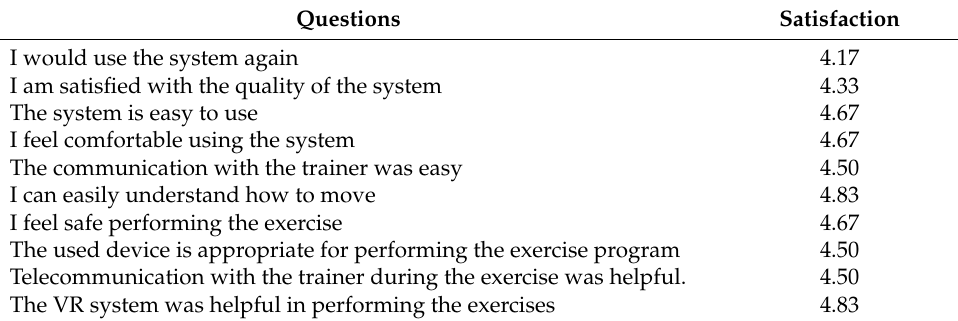
Table 2. Results of modified telerehabilitation